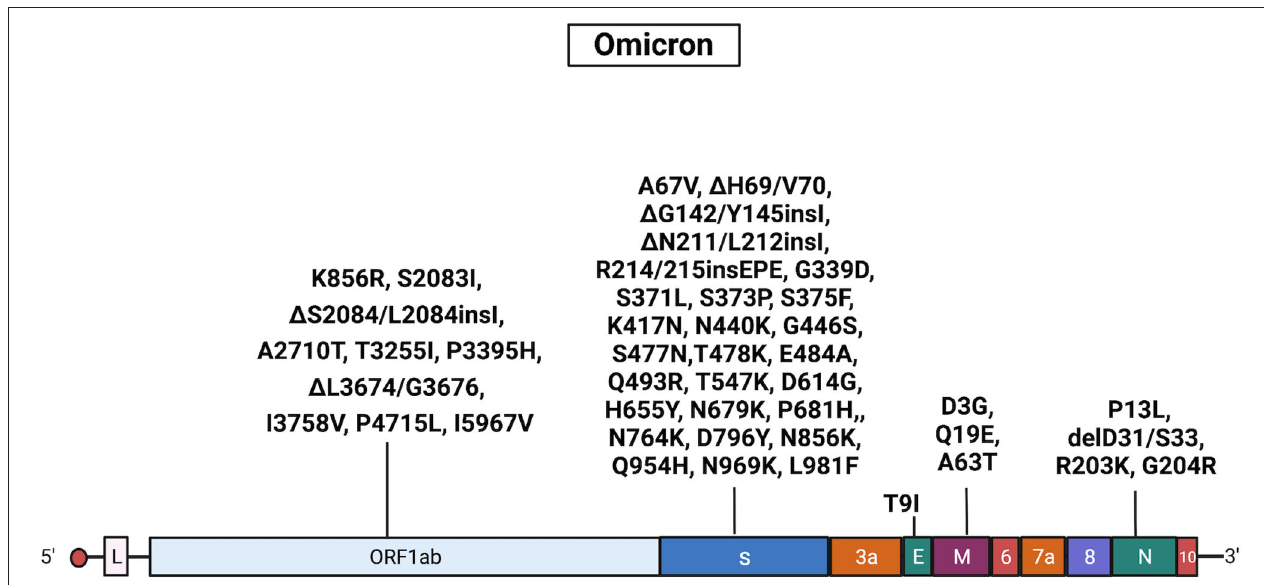
FIGURE 6 | Mutations in Omicron isolates. The figure shows the substitutions identified in the Omicron isolates by NGS. Black, substitutions common to all Omicron isolates. Gene abbreviations: ORF, open reading frame; S, Spike; E, envelope; M, membrane; N, nucleocapsid. Adapted from “Genome Organization of SARS-CoV” by BioRender.com (2022). Retrieved from https://app.biorender.com/biorender-templates.